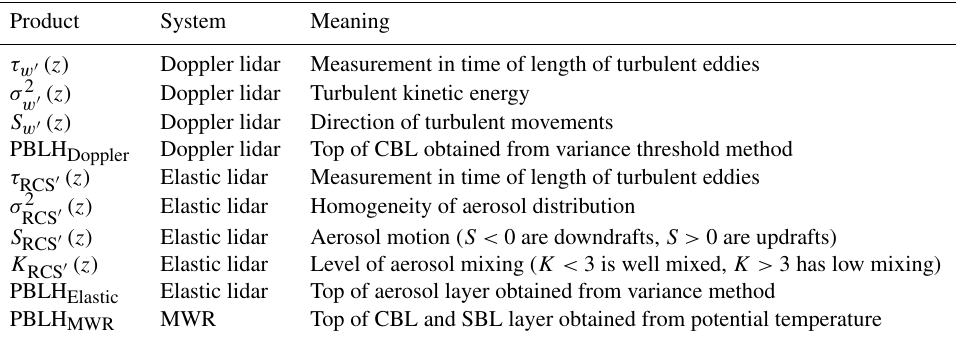
Table 2. Products and their respective meaning, provided by each system.